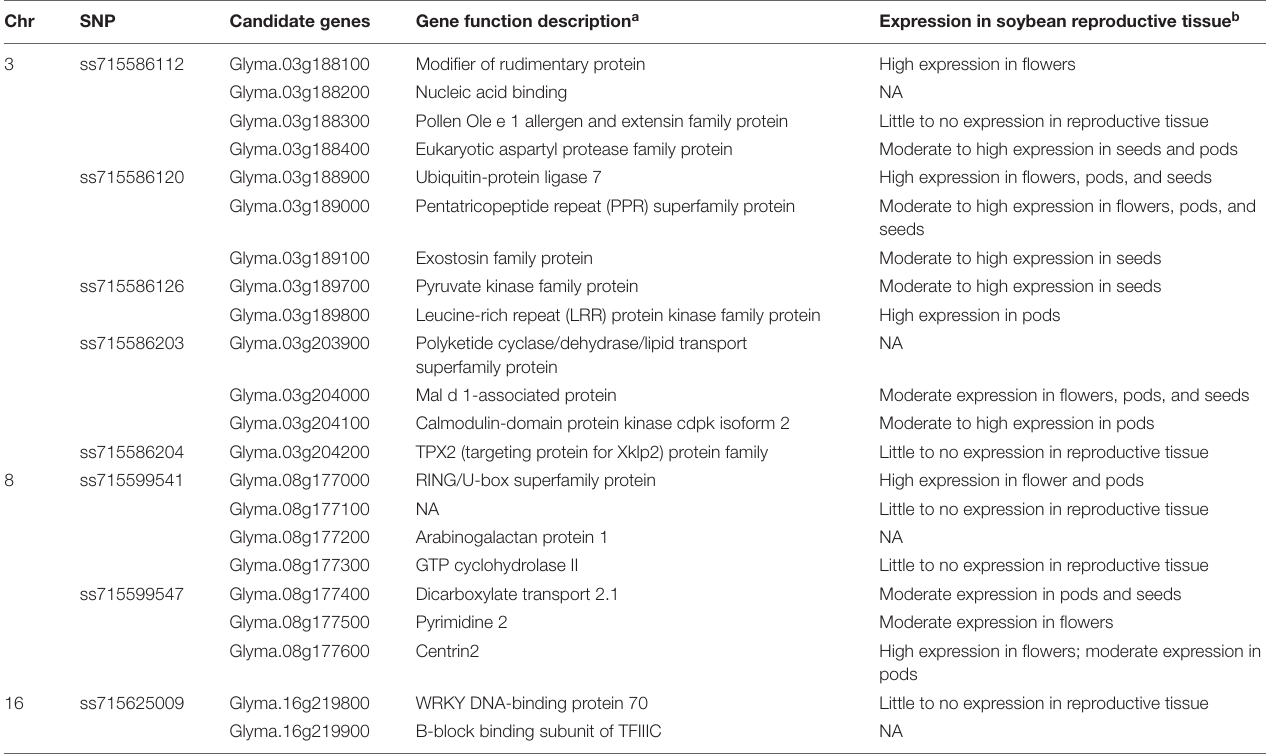
TABLE 3 | Candidate gene models and descriptions within 10 kb flanking regions of significantly associated SNPs using Wm82.a2.v1.